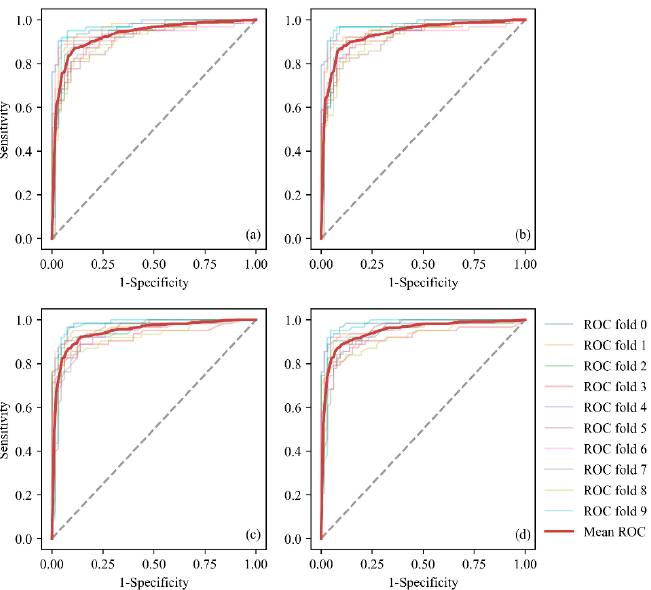
Figure 6. ROC curves of the LR and RF models obtained through 10-fold cross-validation: ( a ) all features of LR, ( b ) EFS of LR, ( c ) all features of RF, and ( d ) EFS of RF.